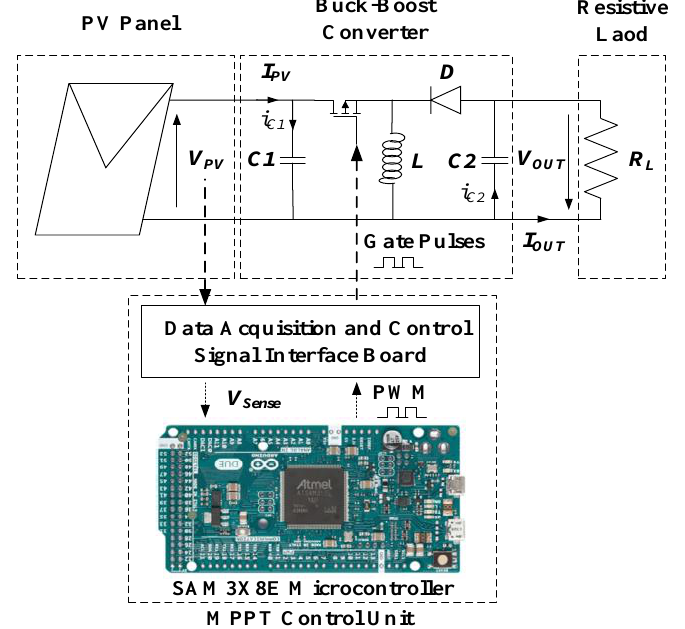
Figure 1. The topology for the PV system under study and its associated MPPT control unit.